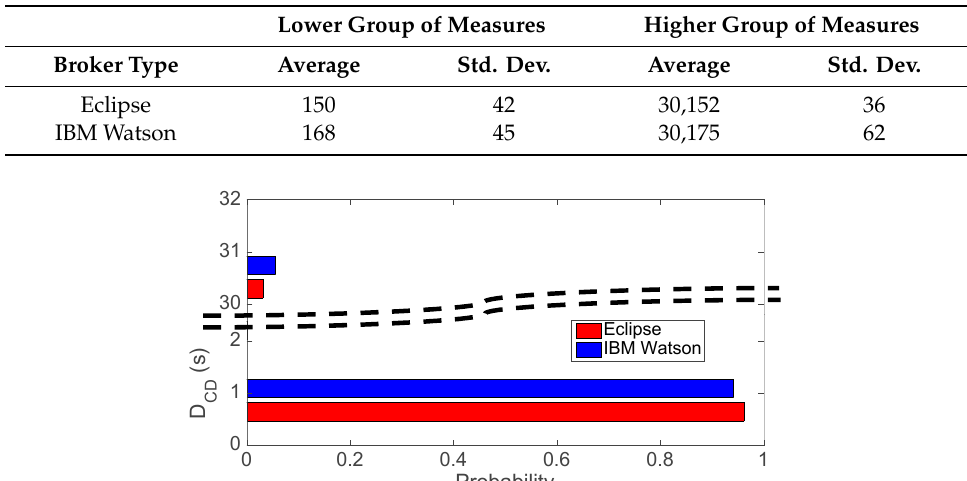
Table 3. Statistics of the D DC (Delay from Database to Cloud user application) collected in the experiments. All values are in milliseconds.